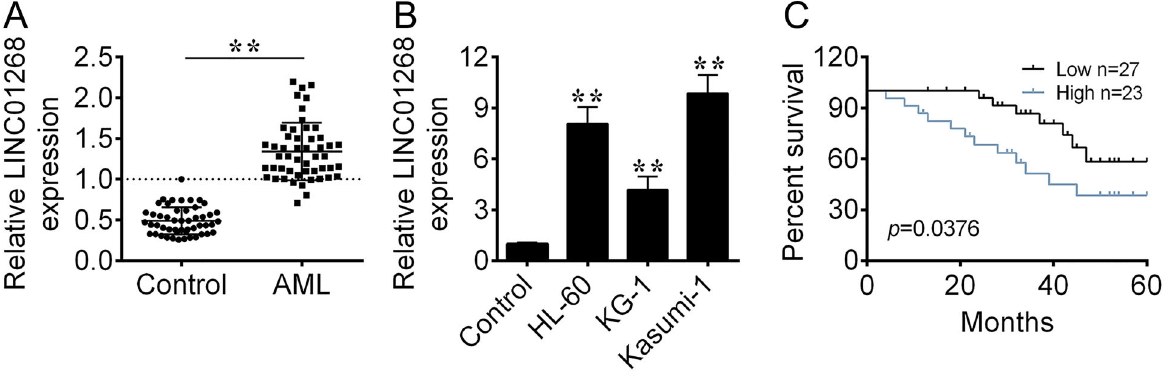
Figure 1. LINC01268 expression was up-regulated in acute myeloid leukemia (AML). A , qRT-PCR was applied to measure the expression of LINC01268 in bone marrow tissues from AML patients and healthy donors (control). B , The expression of LINC01268 in human AML cell lines (HL-60, KG-1, and Kasumi-1) and human bone marrow stromal cell line HS-5 (control) was determined by qRT-PCR. C , Survival curves of AML patients were plotted by the Kaplan-Meier method with the log-rank test. Data are reported as means ± SD. **P o 0.01 vs the control group (ANOVA and t